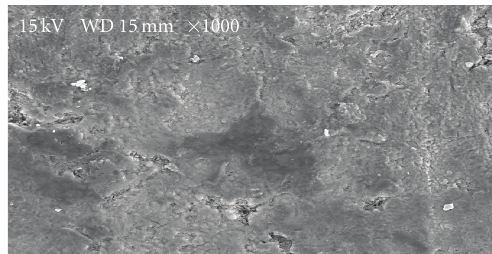
Figure 9: SEM Photograph of mild steel immersed in 1N HCl solution